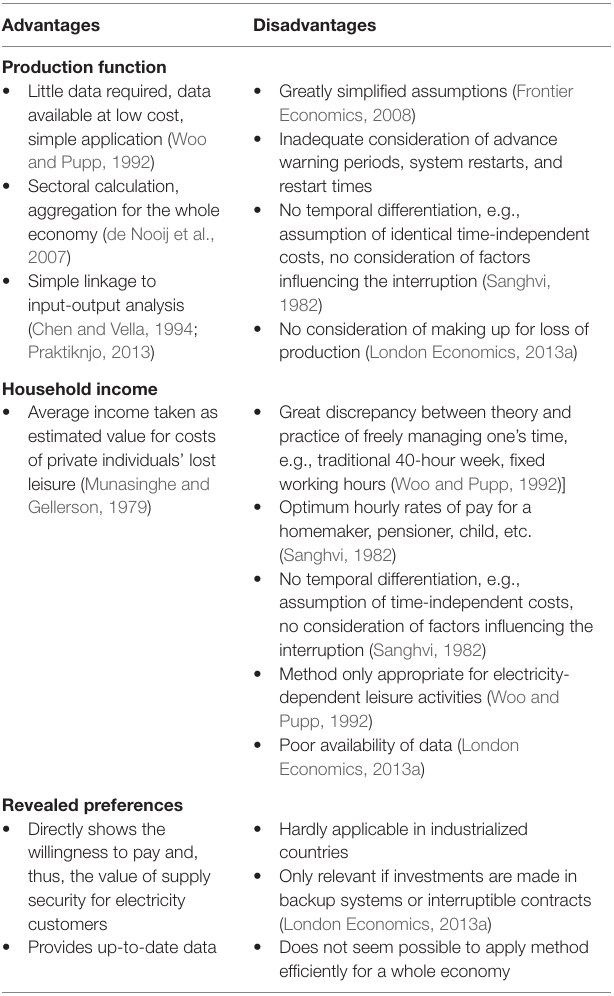
TABLe 5 | Pros and cons of indirect measurement techniques. Advantages